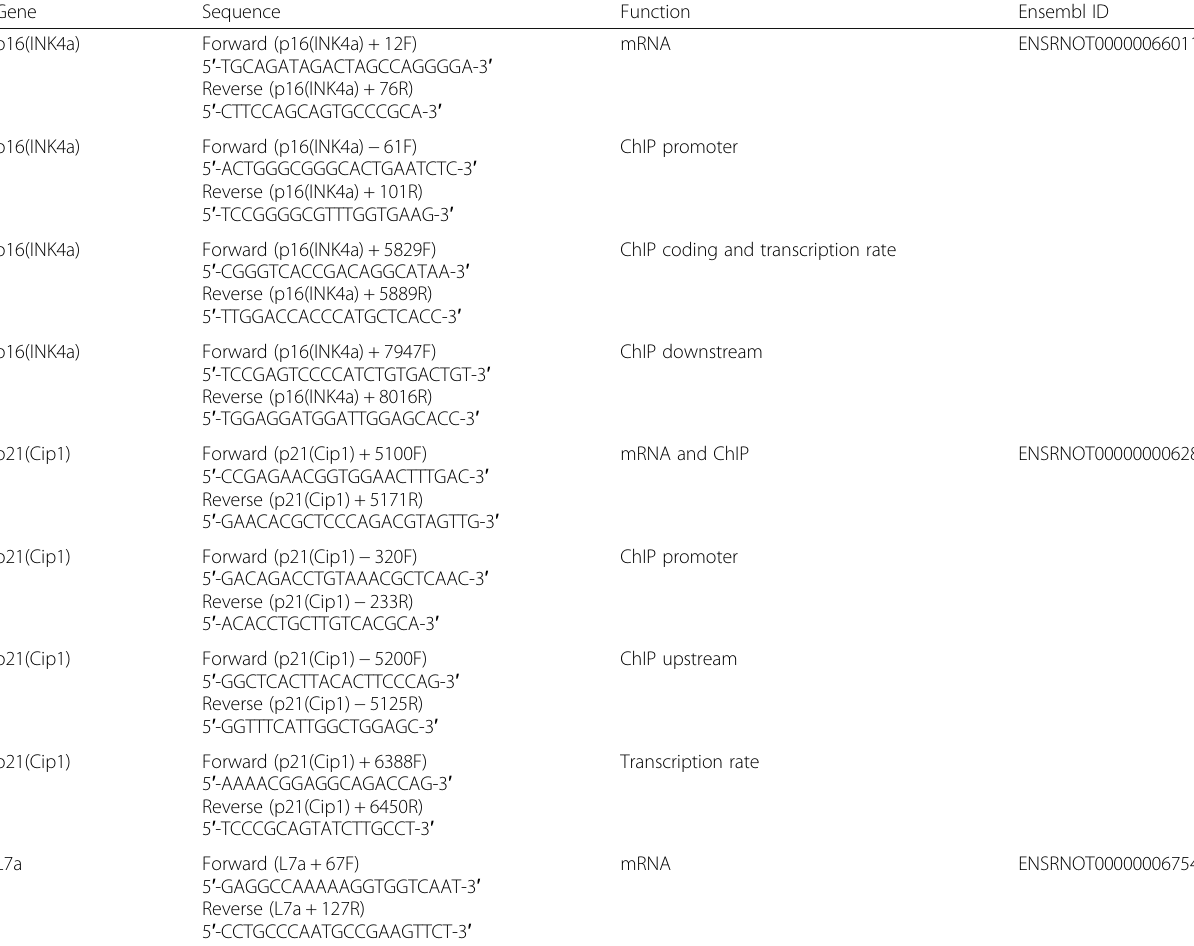
Table 3 Primers, locations, and functions